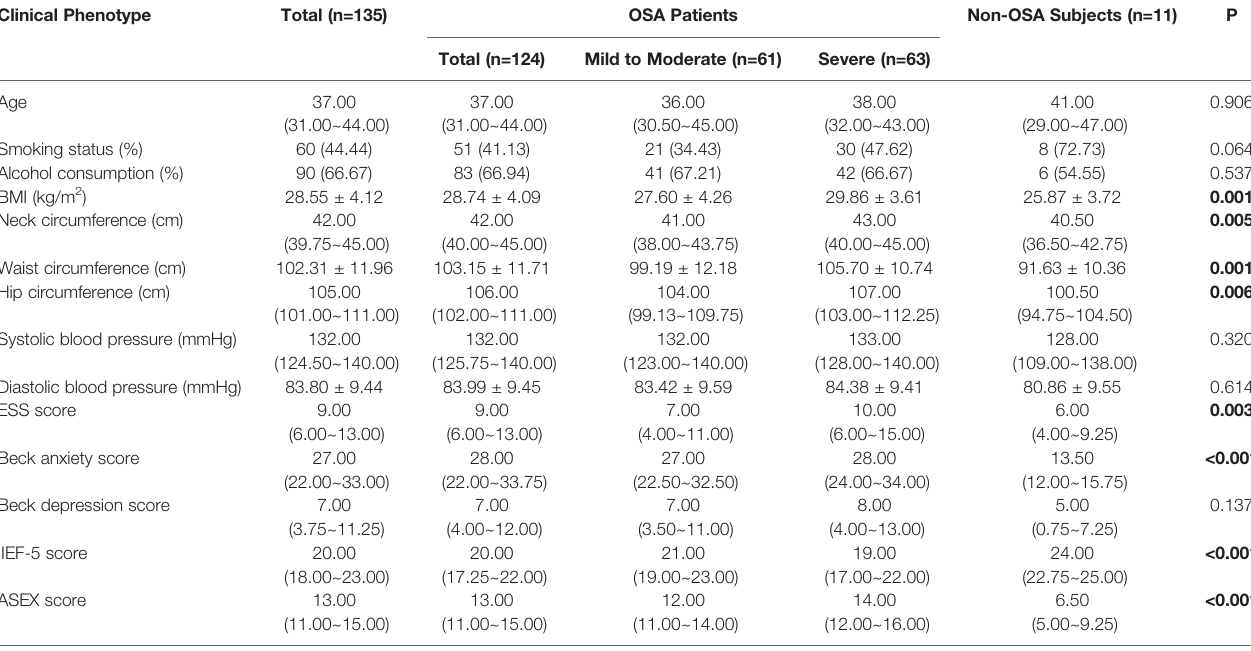
TABLE 1 | Basic demographics and related clinical phenotypes of the population included in the